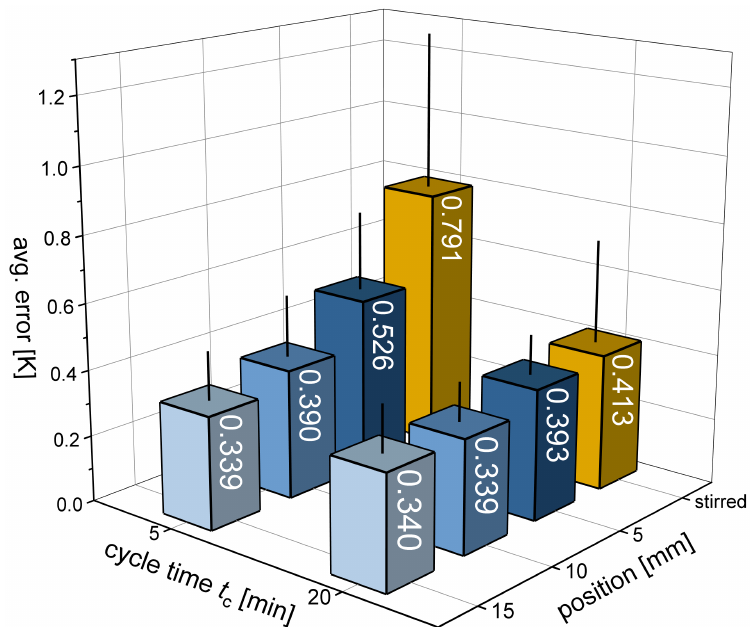
Figure 6. Average error of the temperature profiles achieved from the benchtop plant with regards to the quasi-continuous mini-plant. The black lines represent the standard deviation. Each of the experiments was performed in a fourfold manner. The standard deviations are